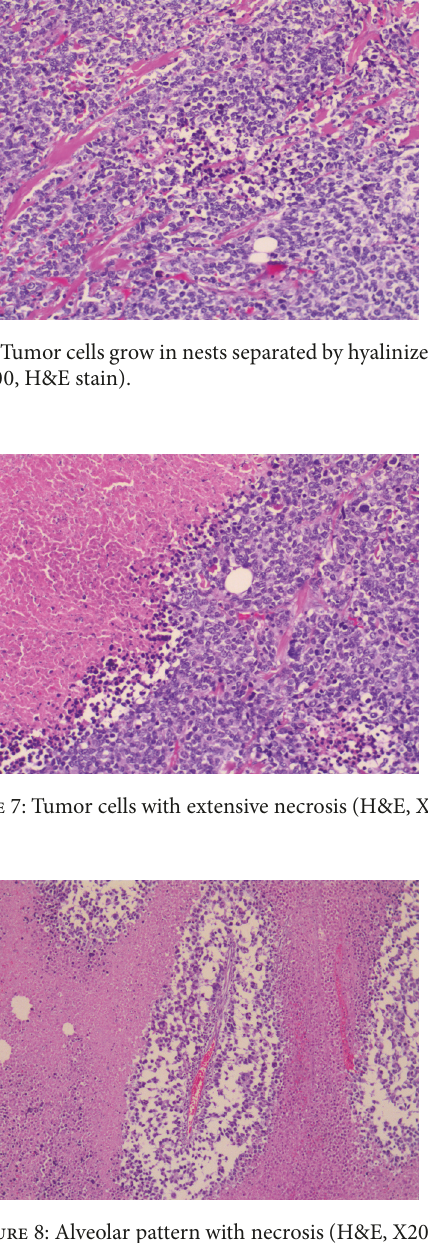
Figure 8: Alveolar pattern with necrosis (H&E, X200).